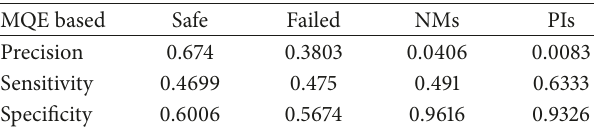
Table 1: MQE based SSSOM performances: precision, sensitivity, and specificity for each class.